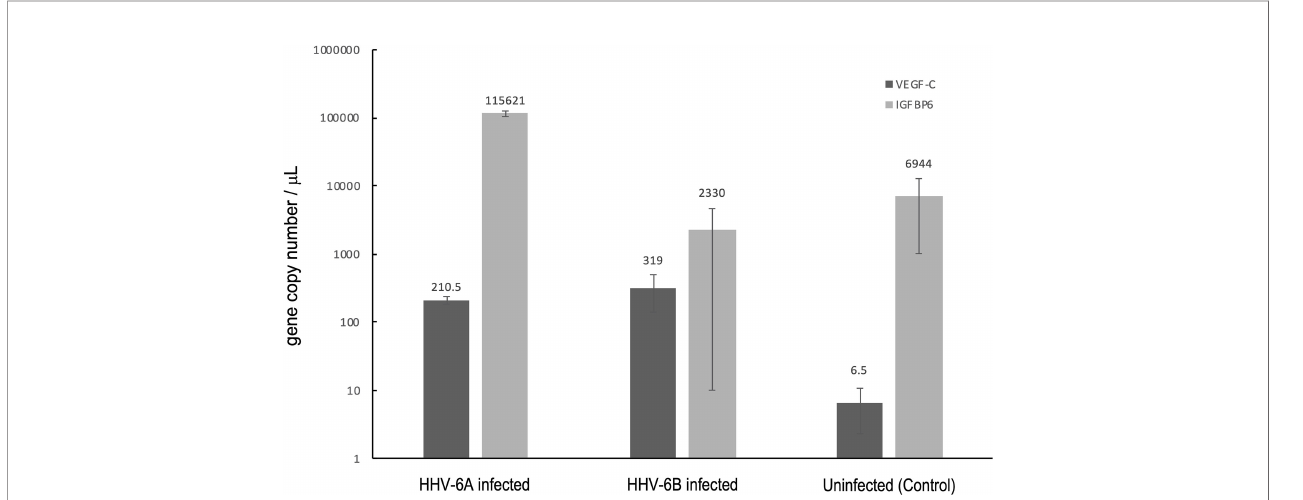
FIGURE 14 | Growth factor responses to HHV6 infection in dHNSCs via RT-qPCR. Expression levels of vascular endothelial growth factor C (VEGF-C) and insulin- like growth factor binding protein 6 (IGFBP6) were measured via RT-qPCR during infection with HHV-6A and HHV-6B. Both HHV-6A(N=3, p=0.0009) and HHV-6B (N=3, p=0.0022) infected dHNSCs show elevated expression of VEGF-C compared to uninfected controls ( dark grey ); (N=3, p=0.0000). HHV-6A infection of dHNSCs also results in increased expression of IGFBP6; (N=3, p=0.0064) while HHV-6B infection does not ( light grey